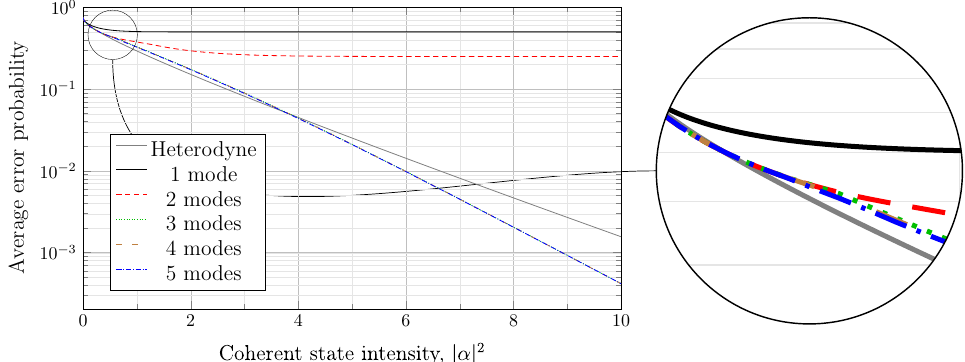
FIG. 2. Average error rate for QPSK signal discrimination with varying signal intensities. Here the number of modes N corresponds to the dimensions of the unitary transformation of the input signal mode and N − 1 ancillary modes. At weak photon numbers ( | α | 2 (cid:3) 0.5), a decoder implementing two modes (single vacuum mode) attains the smallest average error probability. For larger photon numbers ( | α | 2 (cid:2) 1), three modes are optimal and sufficient to outperform heterodyne measurements; using more than three modes does not make any noticeable difference. The magnification on the right-hand side illustrates this clearly.